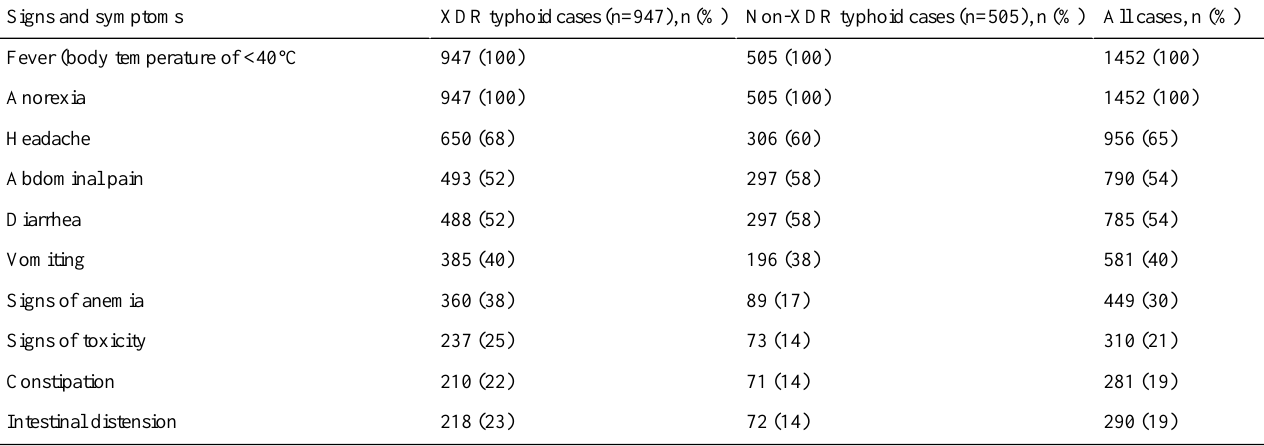
Table 2. Signs and symptoms of patients with XDR a typhoid and those with non-XDR typhoid on hospital admission in Hyderabad, Pakistan, from October 1, 2016, to September 30, 2018 (N=1452).